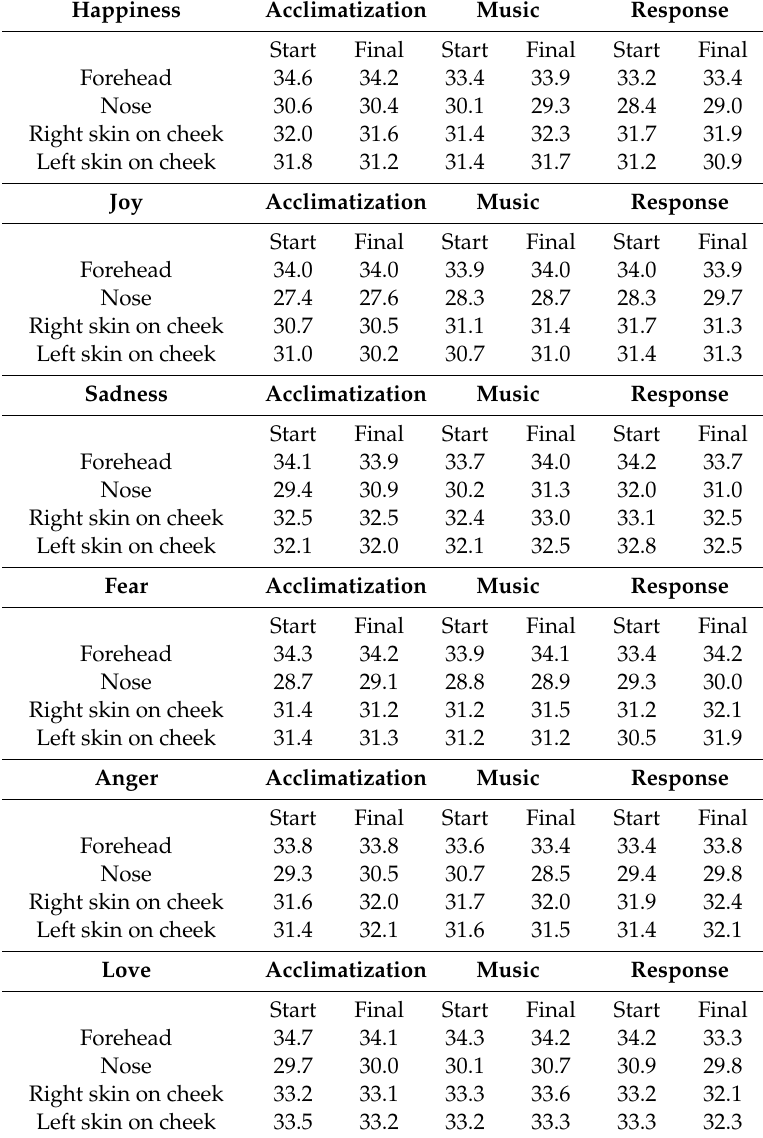
Table 5. Facial average temperatures in each